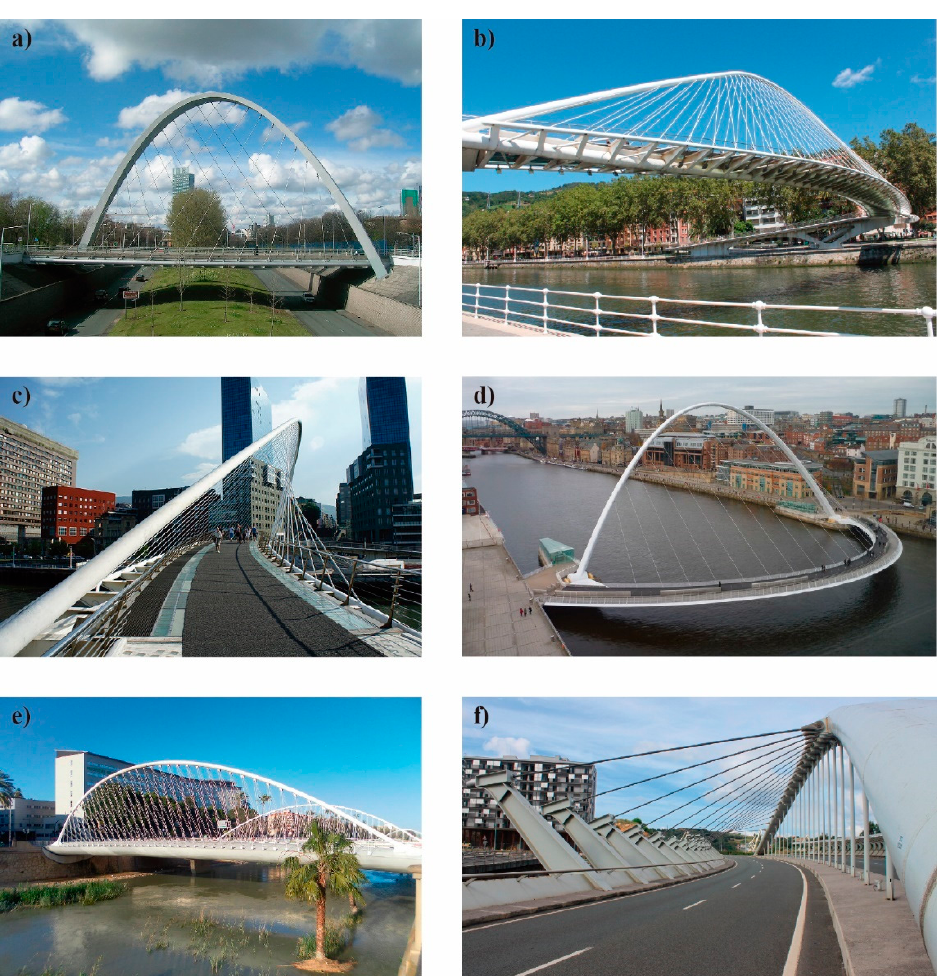
Figure 1. ( a ) Hulme Arch Bridge (photo: Mikey, Wikimedia Commons), ( b ) and ( c ) Campo Volantín Footbridge (photos: Juan Manuel García-Guerrero and Mariordo, Wikipedia), ( d ) Gateshead Millennium Footbridge (photo: Richard West, geograph.org.uk), ( e ) Footbridges of the Hospital General de Murcia (photo: Gregorico, Wikimedia Commons), and ( f ) Arch Bridge over the Galindo River (photo: Juan Manuel García-Guerrero).